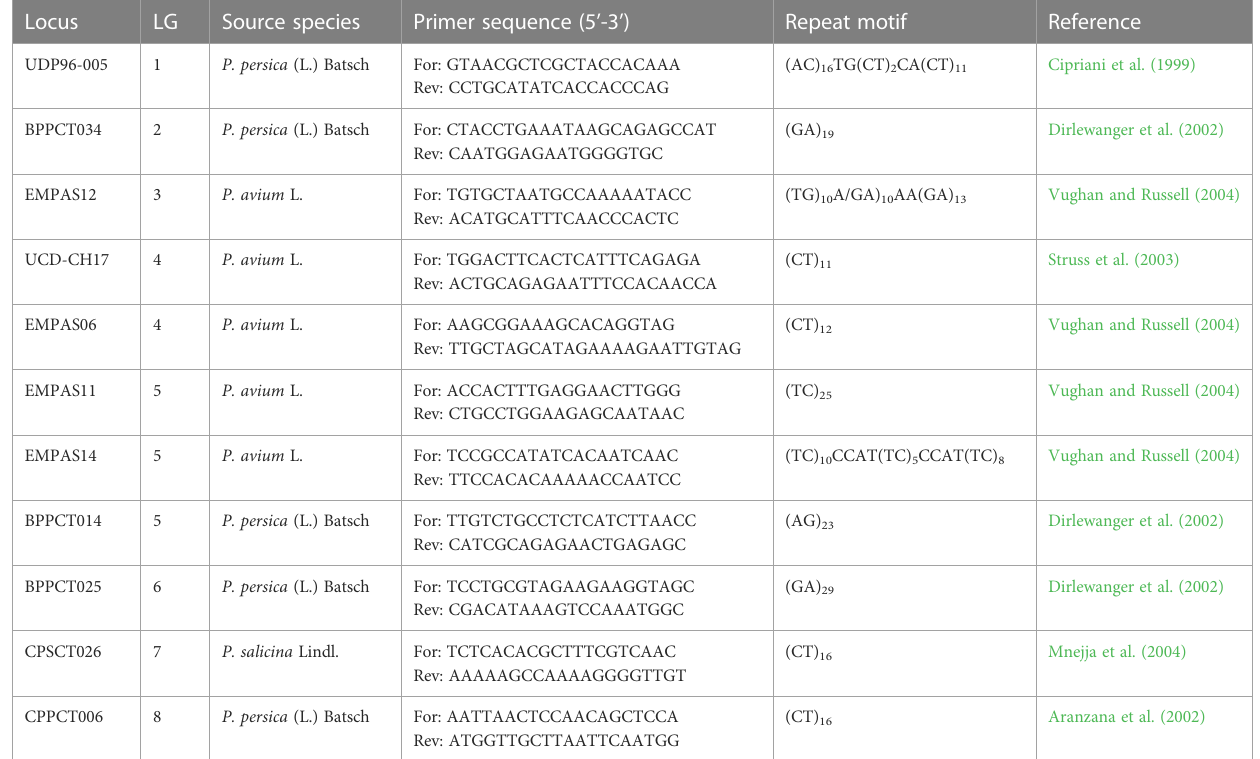
TABLE 1 SSR loci, linkage group (LG), repeat motifs and references of the 11 primer pairs used in this study. Locus LG Source species Primer sequence (5 ’ -3 ’ ) Repeat motif